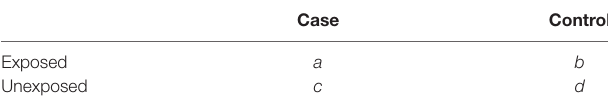
Table 7 | 2 by 2 table of exposure status vs. disease status.